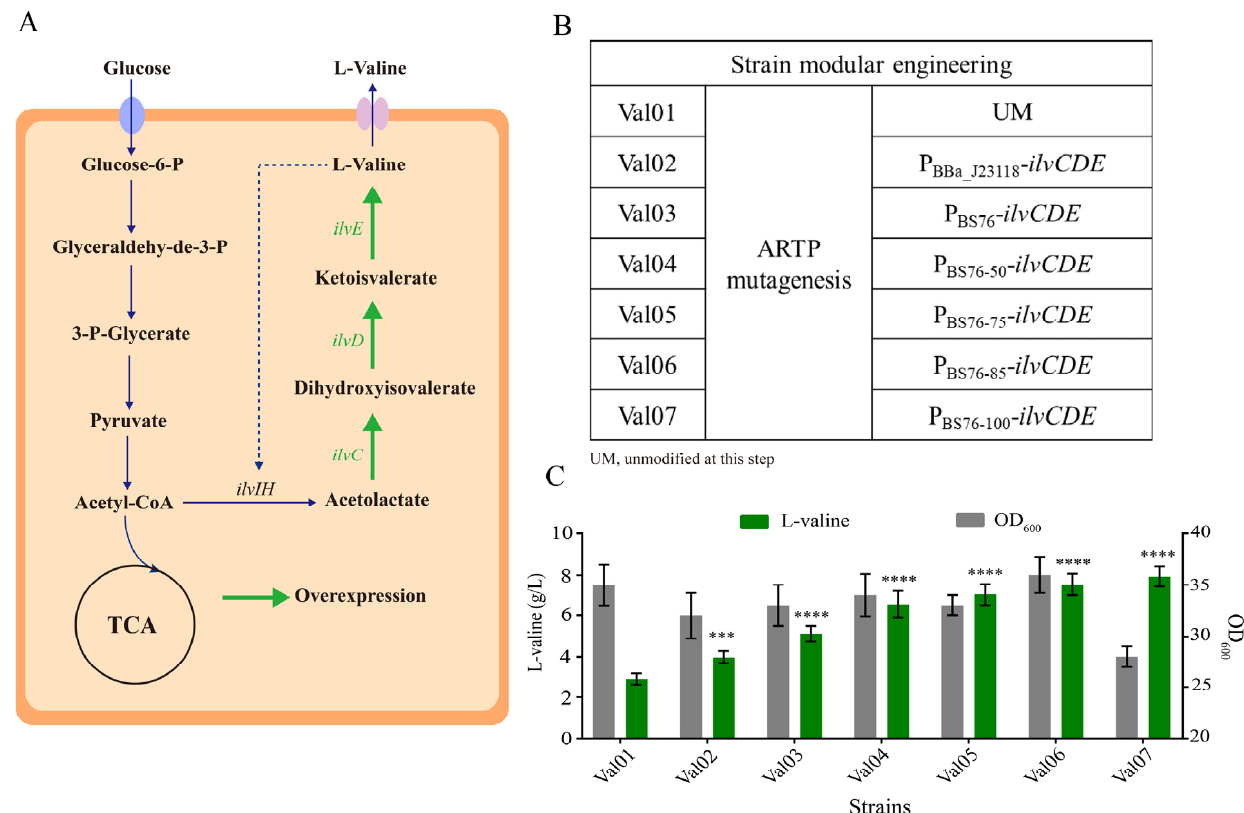
Figure 4. Optimization of the L-valine pathway metabolic flux using the screened gradient promoter in E. coli W3110. ( A ) L-valine synthesis pathway in E. coli W3110. ilvIH , acetolactate synthase; ilvC , acetohydroxy acid isomeroreductase; ilvD , dihydroxy acid dehydratase; ilvE , branched-chain amino acid aminotransferase; dotted line indicates feedback inhibition. ( B ) Enhancing the expression of ilvCDE genes by using the gradient strength promoters. Strains Val02 to Val07 were constructed by overexpressing the ilvCDE genes with promoters P BBa_J23118 , P BS76 , P BS76-50 , P BS76-75 , P BS76-85 , and P BS76-100 in strain Val01. ( C ) L-valine titers of strains Val01 to Val07 were detected in shake-flask fermentation. For ( C ), error bars indicate standard deviations. One-way analysis of variance (ANOVA) was used to examine the mean differences between the data groups. **** p < 0.001, *** p < 0.005.